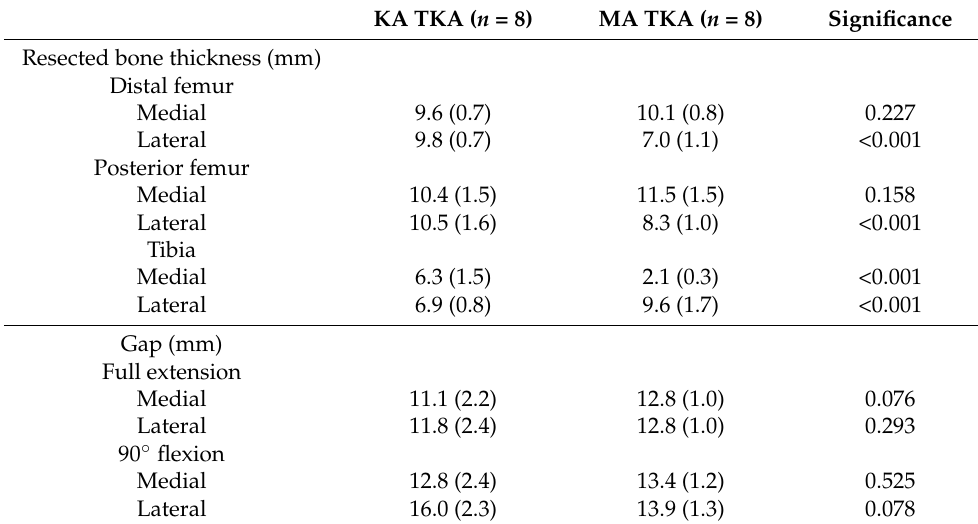
Table 2. Resected osteochondral fragment thickness and gaps after KA and MA TKA.